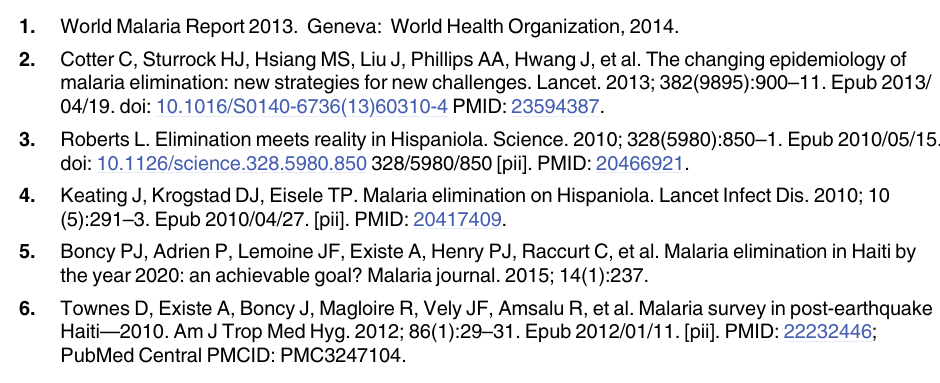
S1 Table. Microsatellite genotypes and allele codes. S2 Table. Multiplicity of infection, mean number of alleles, and heterozygosity by collec- tion year. S3 Table. Number of alleles and heterozygosity across microsatellite loci. across study site and collection year. Estimates were S4 Table. Effective population size, N e, calculated based on both the infinite-allele (IAM) and the stepwise (SMM) mutation mod-